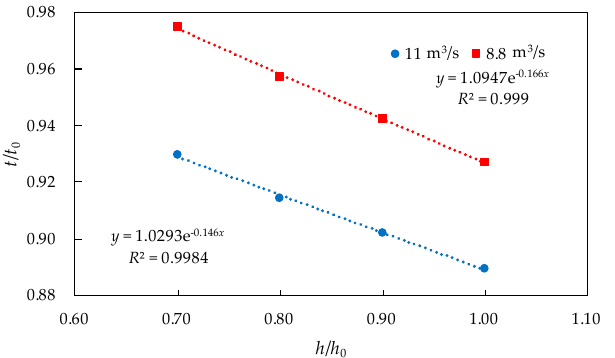
Figure 9. Relationship between h / h 0 and t / t 0 when the upstream discharge was increased by 1.1 m 3 /s.